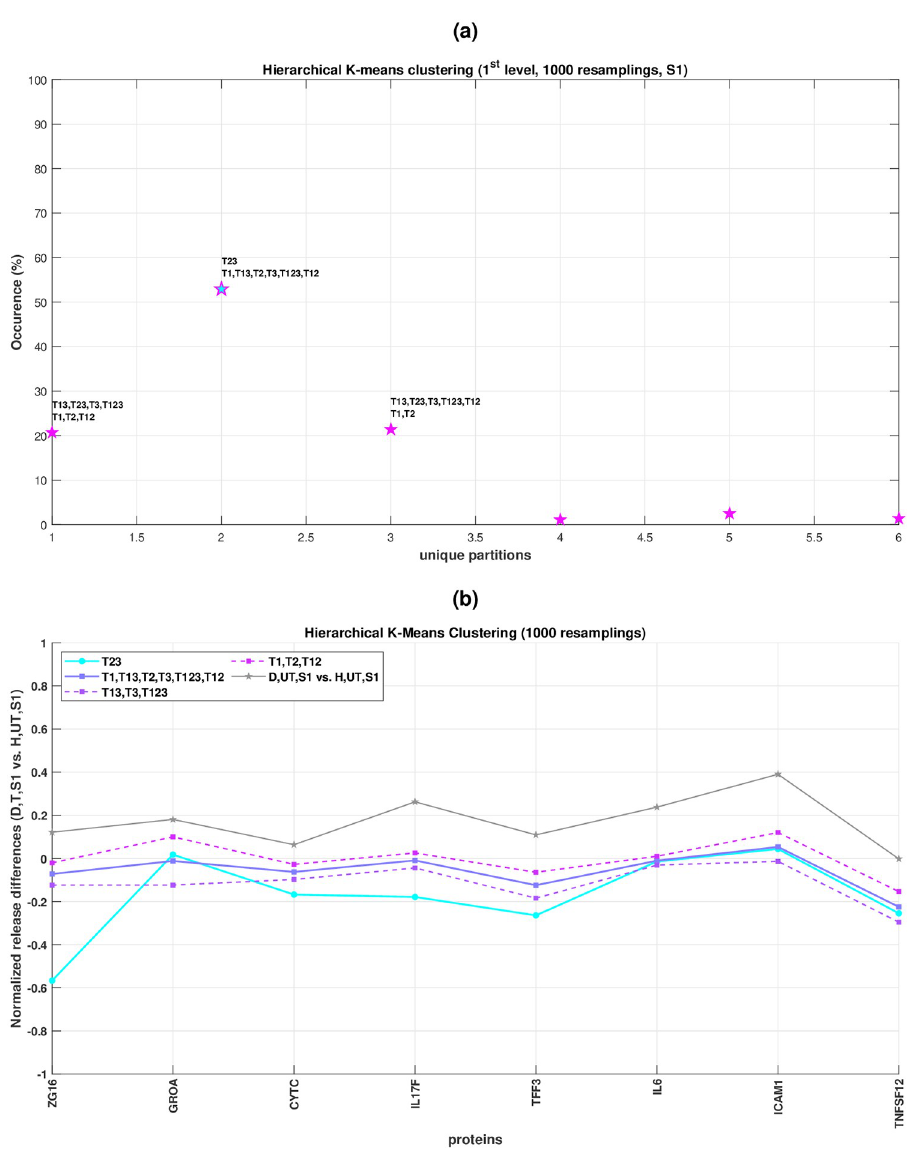
Fig 6. Top-down hierarchical K-Means clustering for stimulation S 1 and N v = 10 3 validation datasets. (a) Frequency/occurrence (%) for all unique partitions/clusters at the first hierarchical level. Annotations are provided for the three most frequent partitions. (b) Visualization of the clustering results after validation; the most dominant partitions at the first and second hierarchical levels are used. Each line corresponds to the centroid of each (sub-) cluster identified representing its restoration capacity defined by the normalized protein release differences between D , treated, stimulated with S 1 ( D , T , S 1 ) and H , untreated, stimulated with S 1 ( H , UT , S 1 ) cells. Solid and dotted lines are used for the first and second hierarchical level respectively. The gray solid line corresponds to the total therapeutic need, meaning the normalized protein release differences between D , untreated, stimulated with S 1 ( D , UT , S 1 ) and H , untreated, stimulated with S 1 ( H , UT , S 1 ) cells, which an ideal treatment should eradicate. The legend shows all treatments per (sub-)cluster identified without employing exhaustive subset search since only 7 treatments were used in